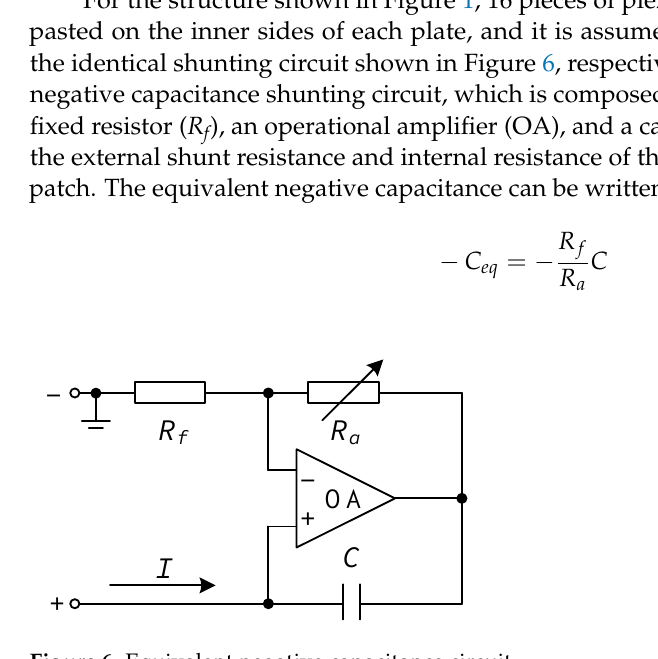
Figure 6. Equivalent negative capacitance circuit. Table 1. Properties of one periodic element.